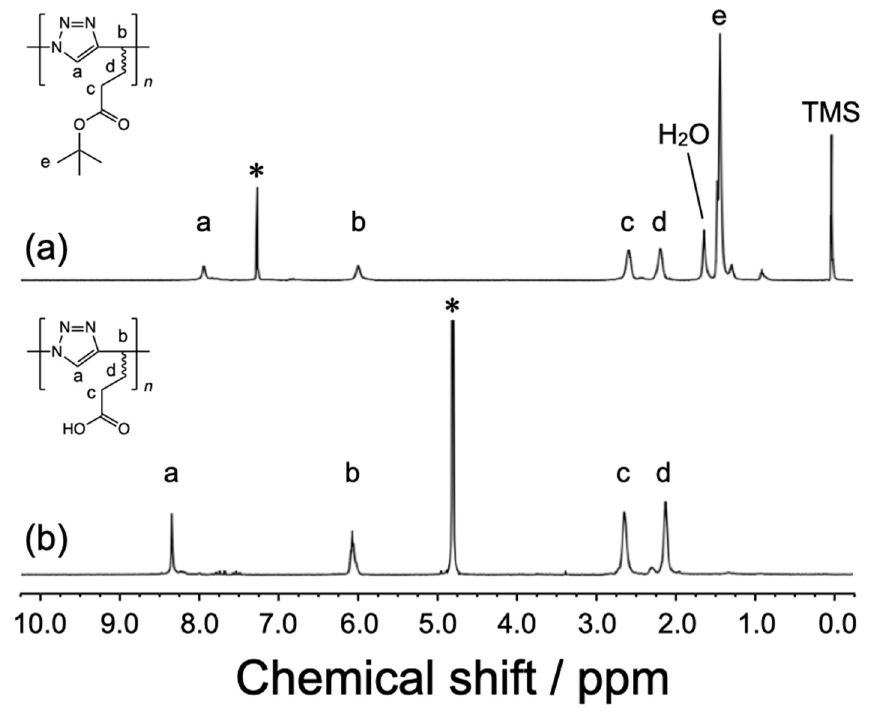
Figure 1. 1 H NMR spectrum for poly(tBuAH) (CDCl 3 ) ( a ) and poly(AH) (D 2 O) ( b ). Assignments are indicated as a, b, c, d, and e. Asterisks denote the signals due to the residual protons in solvents.